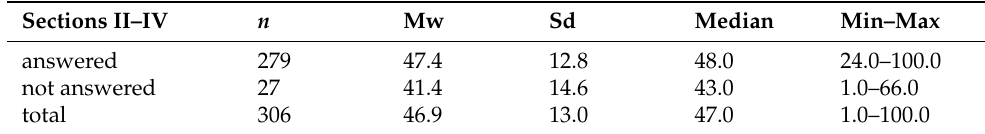
Table 2. Age of participants